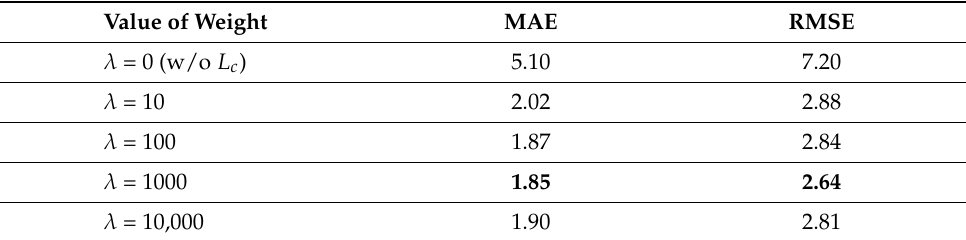
Table 5. Estimation errors for different values of